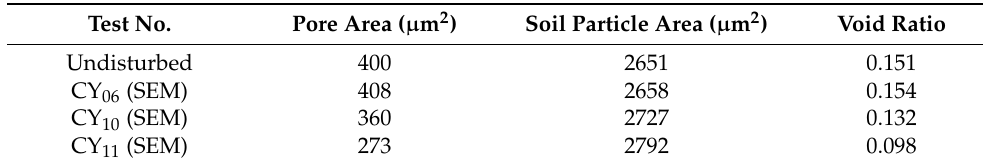
Figure 15. The microstructure of the soft soil after cyclic loading with different degrees of reconsolidation: ( a ) undisturbed soil; ( b ) CY 06 ; ( c ) CY 10 ; ( d ) CY 11 . Table 3. The area of pore fractions and soil